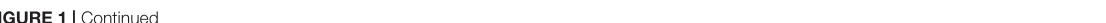
by individual M. oryzae isolates using Exonerate to analyze their variation within M. oryzae ( Supplementary Table 5